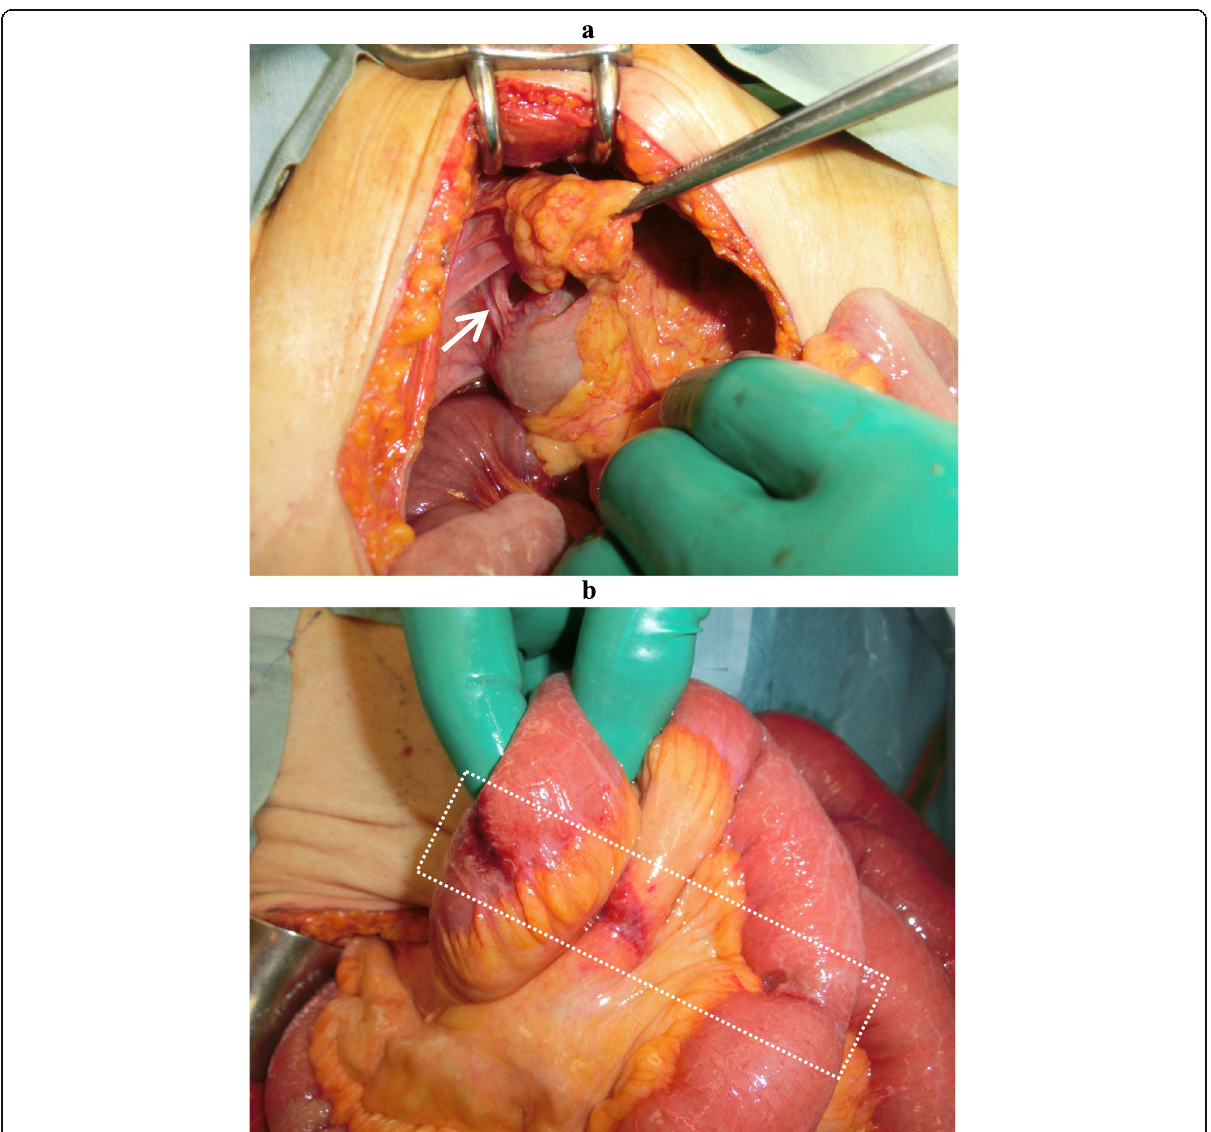
Fig. 2 Intraoperative findings. a The hernia orifice located lateral to the ascending colon in the right paracolic gutter and posterior to the omentum (arrow). b The strangulated part of the closed loop bowel revealed no stenosis or ischemic